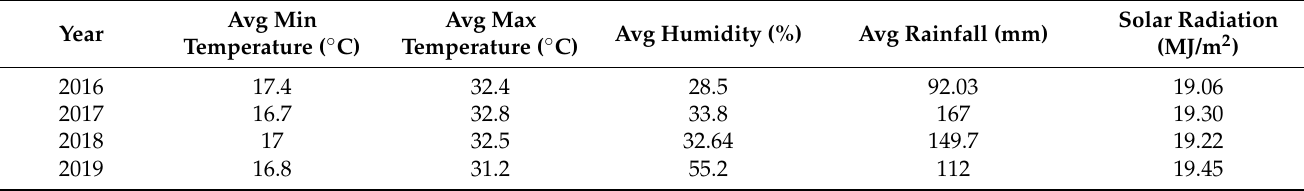
Table 2. Weather input data for calibration.